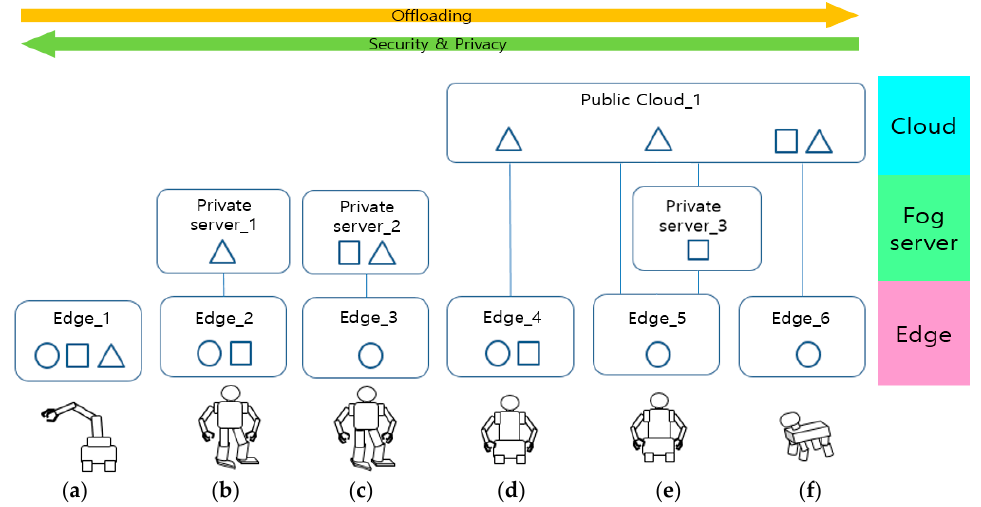
Figure 4. Various distribution of robot functions and offloading levels: ( a ) stand-alone type; ( b ) and ( c ) use private servers for offloading computation burden; ( d – f ) adopt clouds. The proposed FaaS-FR adopts model ( e ).